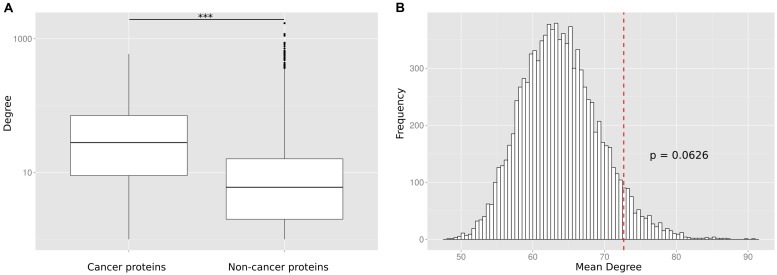
(A) Without correcting for the study bias the PPI degree difference between cancer proteins and non-cancer proteins is highly significant (∗∗∗
p < 10-16). (B) The number of PPIs is not significantly enriched for cancer proteins as compared to equally frequently studied random protein sets. The histogram shows the mean degree of 10,000 random gene sets with the same bait usage distribution as the cancer protein set. The position of the red dotted line indicates the mean degree of the cancer protein set. The p-value is computed as the fraction of times the mean degree of the randomized set was larger than the observed mean degree and is not significant (p = 0.0626).